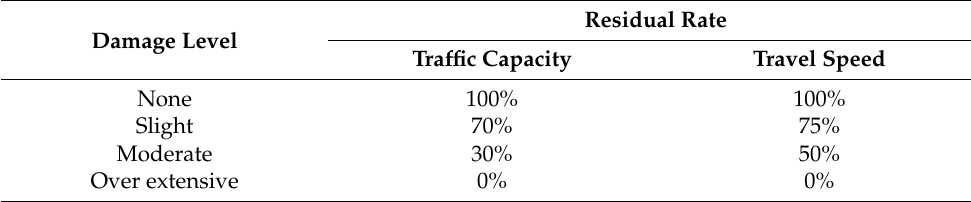
Figure 1. Flowchart of emergency path search algorithm. Table 1. Relationship between damage level and residual serviceability of